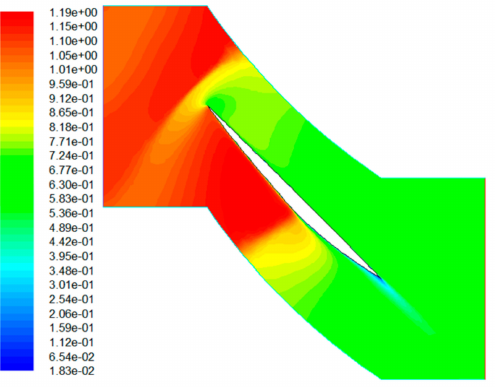
Figure 28. Contours of the Mach number for the third designed blade cascade.